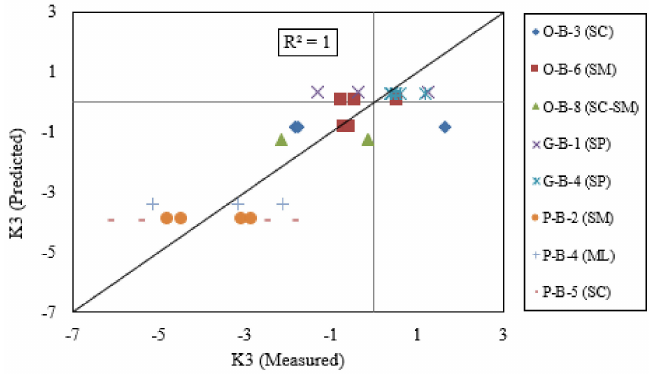
Figure 7. Predicted versus Measured Model Coefficients.